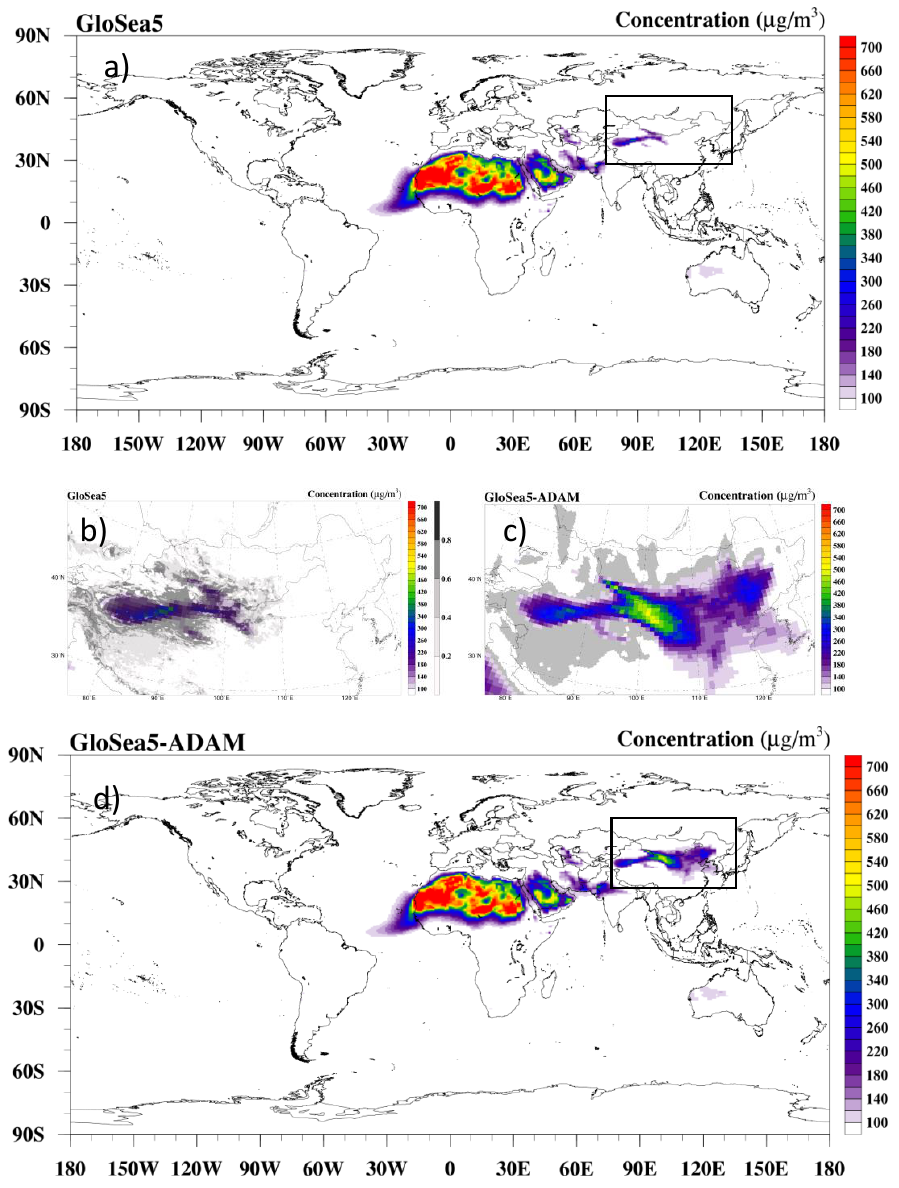
Figure 2. ( a ) The global distribution of mean PM 10 mass concentrations simulated (from 1 March to 31 May 2017) by GloSea5 and ( b ) a close-up view of Northeast Asia. ( c ) close-up of Northeast Asia. Unit: µ g m − 3 and ( d ) Global distribution simulated by the GloSea5-Asian Dust and Aerosol Model (ADAM). The gray area in ( b ) is bare soil fraction over 0.2 and in ( c ) indicates the Asian dust source regions in ADAM.